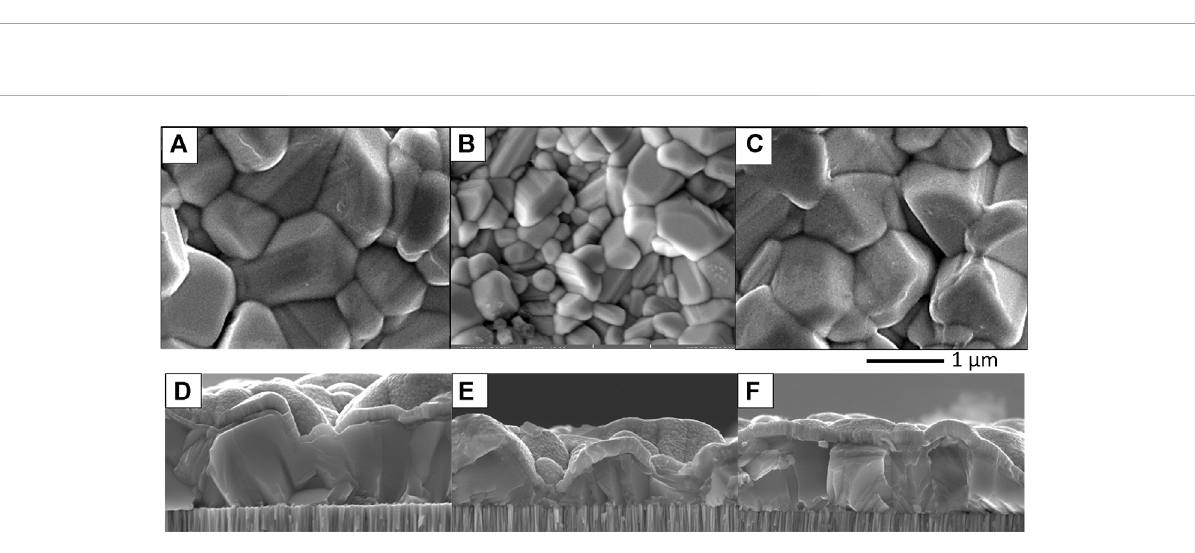
FIGURE 10 Top-down and cross-sectional SEM images of reference substrate (A,D) , MoO x (B,E) and NiO (C,F) of Sb 2 Se 3 fi lms deposited by thermal evaporation.